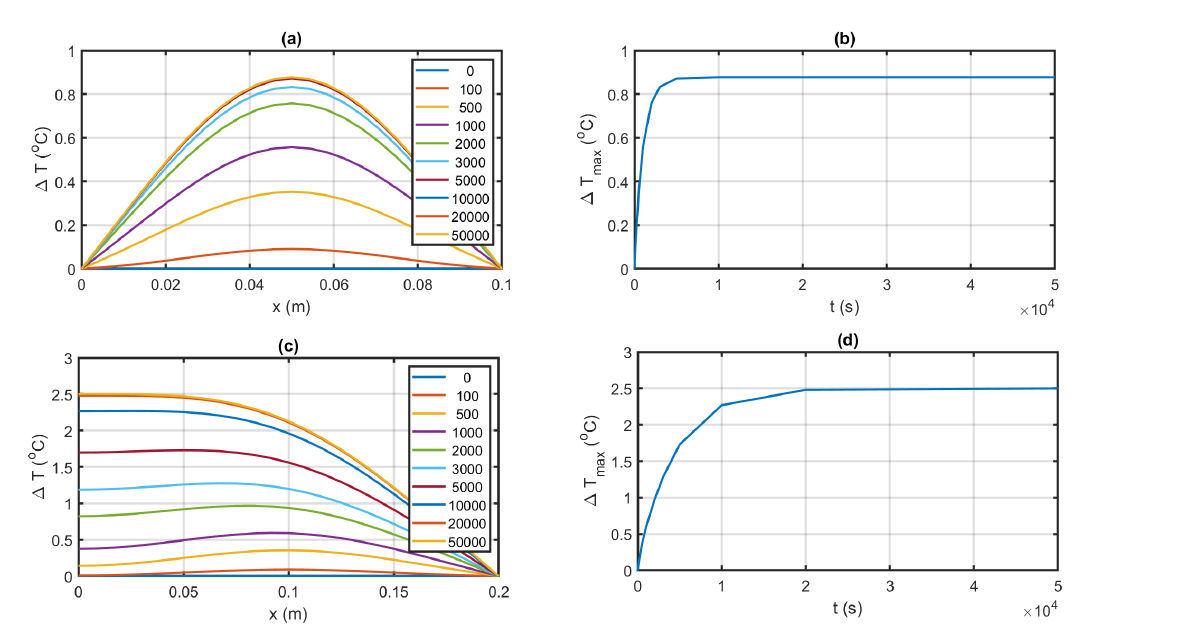
Figure 25. Temperature profiles inside liquid part of PCM cell ( a ) constant temperature BC at the both sides, ( b ) maximum temperature while constant temperature BC at the both sides, ( c ) adiabatic BC at the left, ( d ) maximum temperature while adiabatic BC at the left.